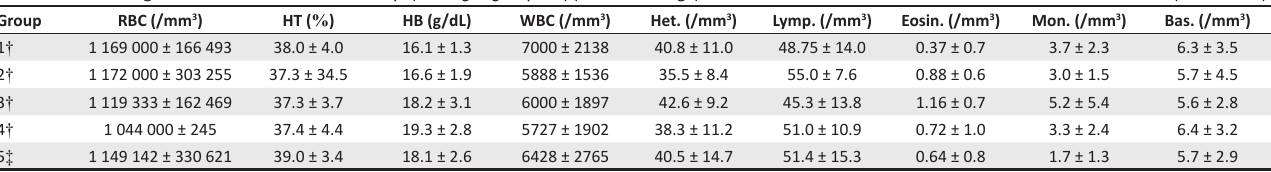
TABLE 6: Haematological values in female bronze turkeys ( Meleagris gallopavo ) (48 weeks of age) vaccinated with various commercial strains of Newcastle disease (mean ± s.d.). Group RBC (/mm 3 ) HT ( % )